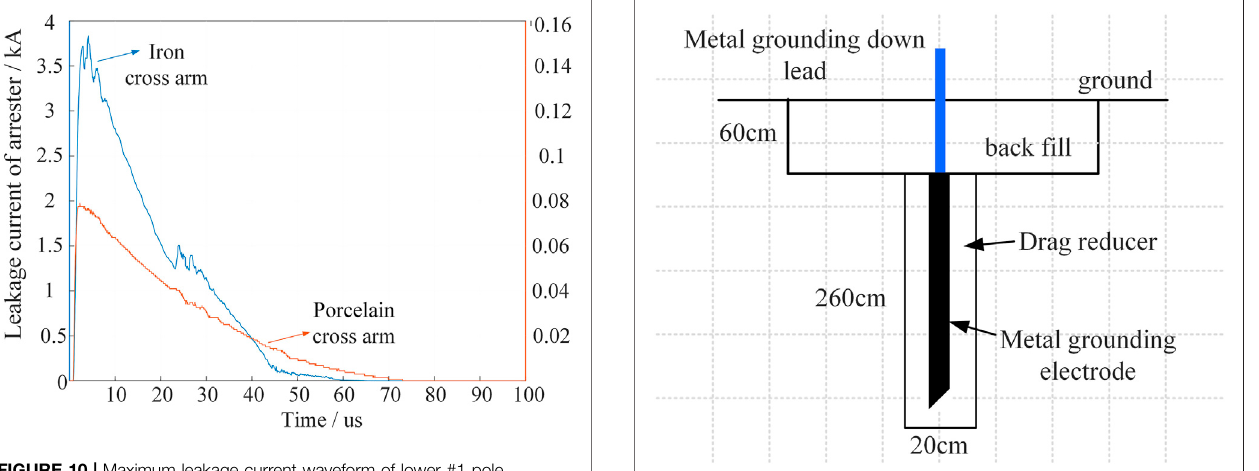
FIGURE 10 | Maximum leakage current waveform of lower #1 pole arresterinvadedby30 kAlightningcurrentamplitudeofcrossarmsofdifferent materials.